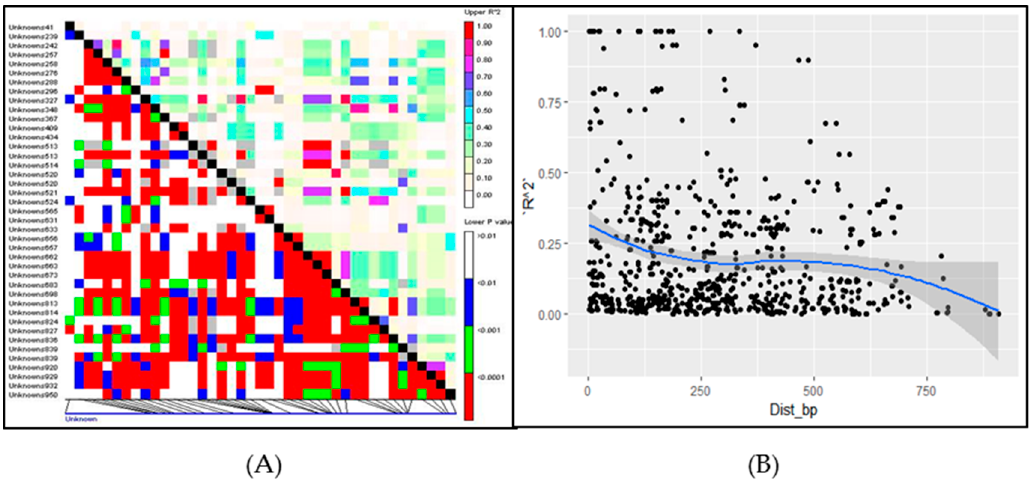
Figure 5. ( A ) Linkage disequilibrium pattern; ( B ) linkage disequilibrium (LD) decay of ZmNAC9 in 111 maize lines.